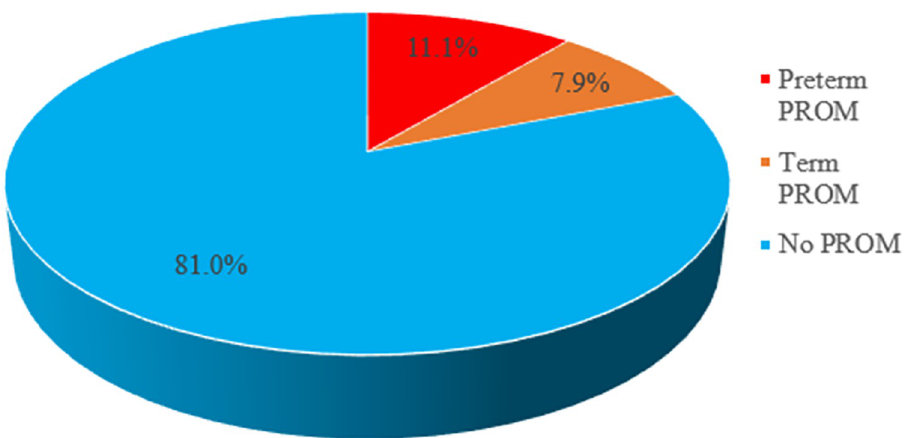
Fig 1. Magnitude of PROM among pregnant women admitted to the maternity ward at Debre Markos Referral Hospital.